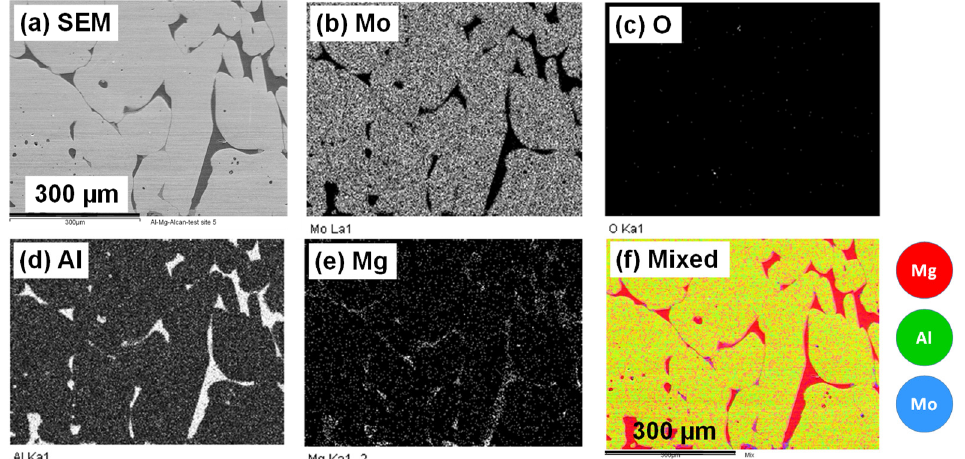
Figure 14. ( a ) SEM imaging on the Al ‐ Mg alloy solidified next to the Mo ‐ block surface, showing bulk Al ‐ Mg (deeper and dark regions), the outer and brighter Mo ‐ Al alloy coating, with EDX elemental mapping for ( b ) Mo, ( c ) O, and ( d ) Al, which is associated with ( e ) Mg, while ( f ) is the mixed color image.